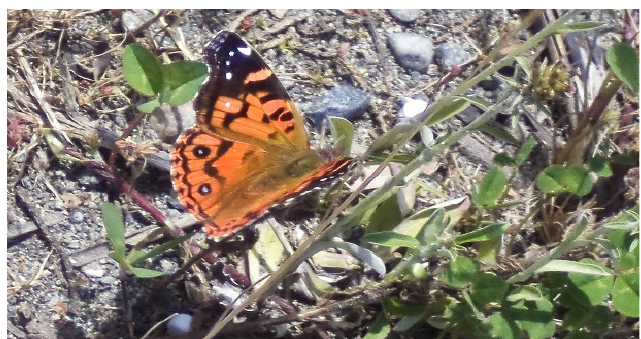
Figure 5: Ecosystem interactions between a butterfly and a patch of